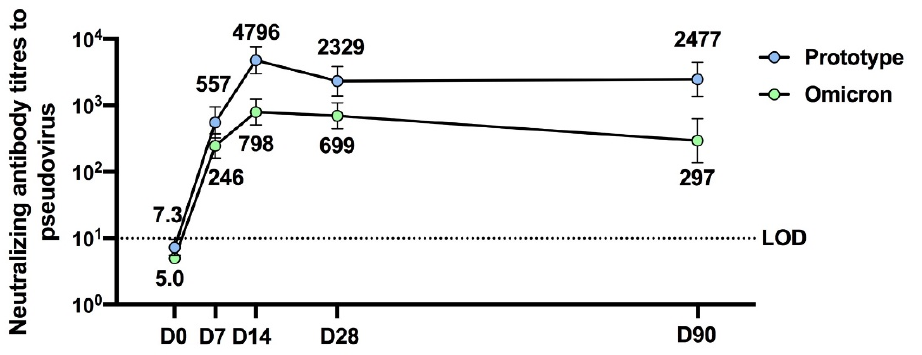
Figure 2. Three-month neutralizing antibody durability against prototype SARS-CoV-2 and Omicron Figure 2. Three ‐ month neutralizing antibody durability against prototype SARS ‐ CoV ‐ 2 and Omi ‐ cron BA.1 strain after the bivalent V ‐ 01D ‐ 351 booster following primary series of inactivated vac ‐ BA.1 strain after the bivalent V-01D-351 booster following primary series of inactivated vaccines ( n = cines ( n = 20).